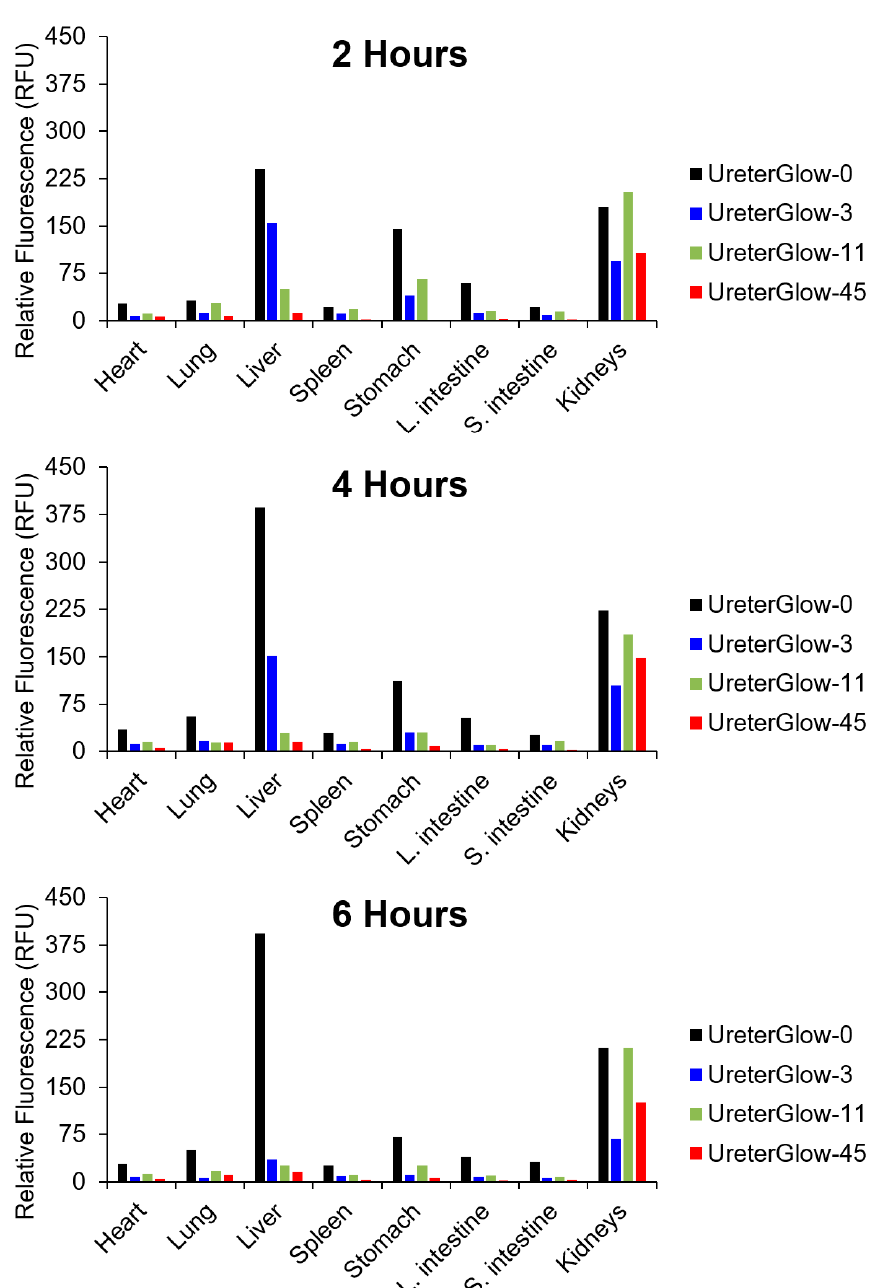
Figure 3. Quantitation of in vivo biodistribution of UreterGlow conjugates. Mice were administered 10 nmol of various conjugates ( n = 1 per time point per conjugate) via tail vein injection. After varying times, mice were euthanized and their organs were removed. Organs were imaged, fluorescence intensity was recorded, and relative fluorescence was plotted.